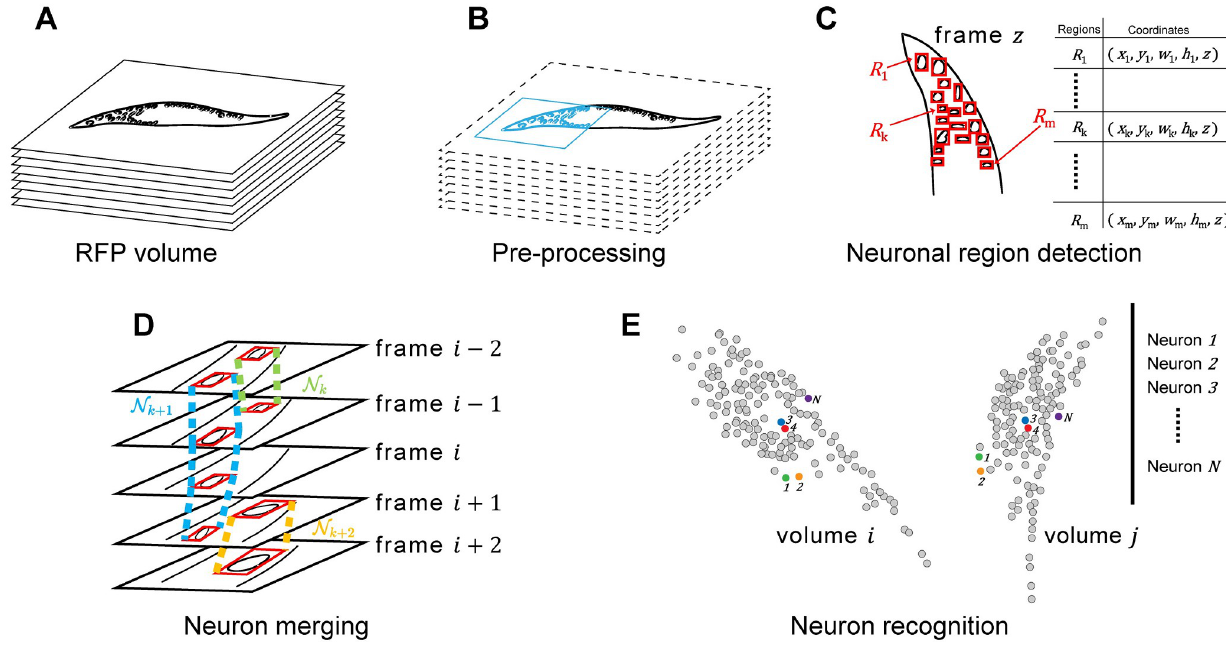
Fig 1. The CeNDeR pipeline. (A) A red channel (RFP) imaging volume consists of a stack of fluorescence images (1024 × 1024 × 18, see Section Imaging setup for further details). (B) An Automatic Pre-Processing (APP) algorithm crops the head region (blue rectangle) and defines the C. elegans coordinate system. (C) A Multi-Field Detection (MFD) algorithm generates anchor boxes of different sizes centered at local maxima of pixel intensities. An ANN refines the shapes and locations of anchor boxes and proposes neuronal regions R (red rectangle) in every frame, each of which is represented by a quintuple ( x , y , w , h , z ). (D) A 3D merging procedure views regional alignment across adjacent frames as a maximum bipartite matching problem, solved by the Hungarian method. N , N and N illustrate how the procedure merges neuronal regions into three neuron objects. (E) A multi-class k k þ 1 k þ 2 recognition neural network takes designed feature vectors and assigns an digital identity to every neuron in a volume. Neurons sharing the same identity are represented by the same color. N is the number of neurons to be